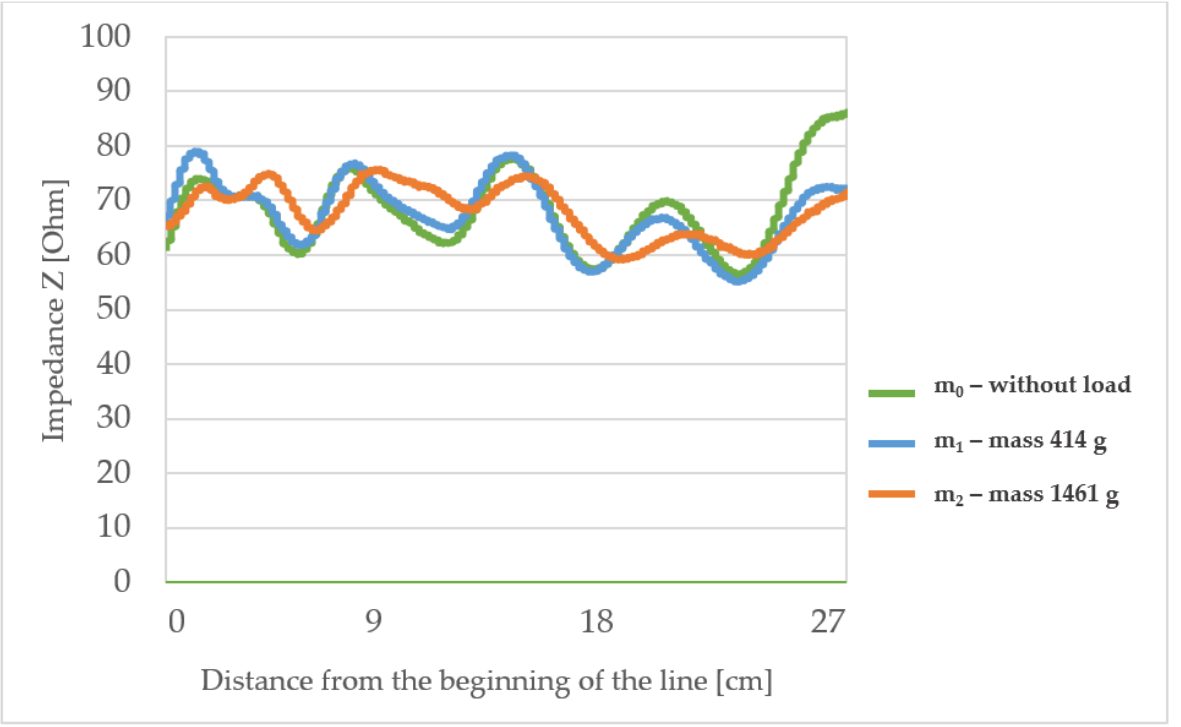
Figure 7. The profiles of the characteristic impedance of the textile signal line L2.